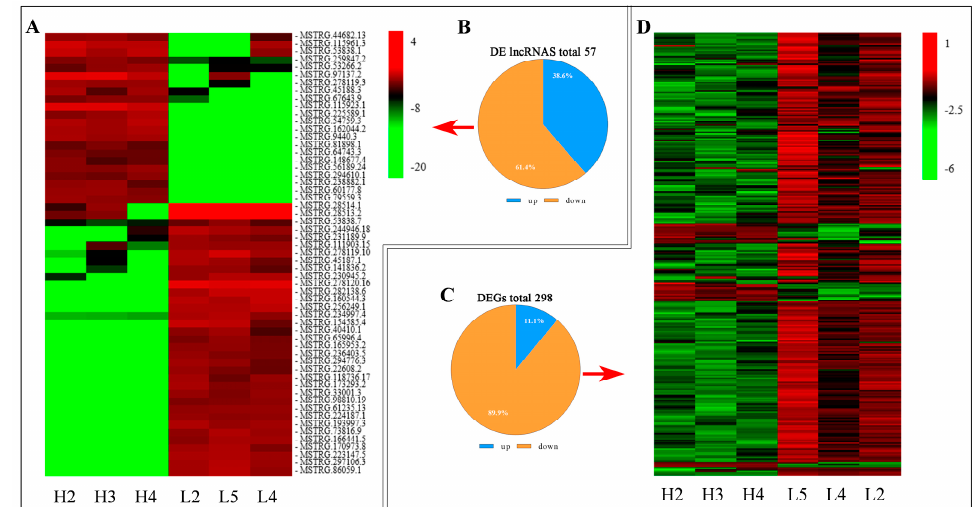
Figure 3. The number of differentially expressed (DE) lncRNAs and DE genes (DEGs) in H and L groups comparisons. ( A ) The hierarchical cluster of DE lncRNAs. ( B ) Total number of up-regulated and down-regulated DE lncRNAs in each comparison. ( C ) Total number of up-regulated and down-regulated DEGs in each comparison. ( D ) The hierarchical cluster of DEGs.